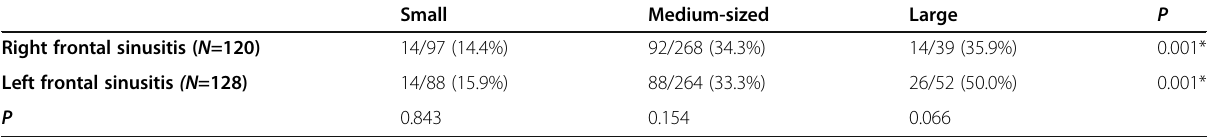
Table 5 Relationship between the type of frontal sinus and the frequency of sinusitis for both sides